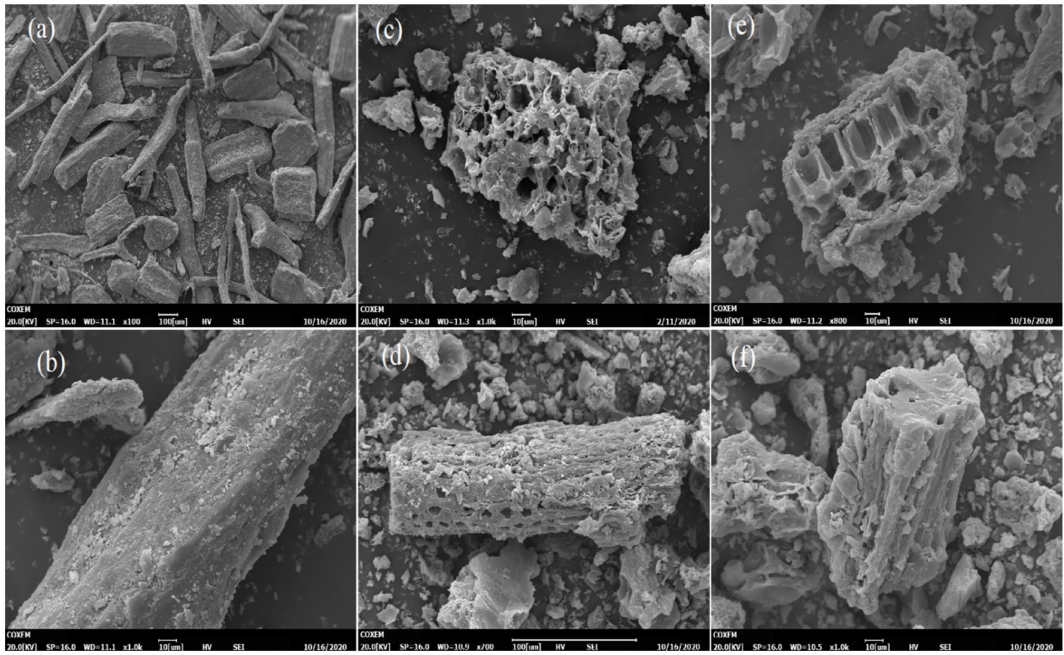
Figure 3. SEM micrographs of activated carbon ( a , b ) from raw Quercus alba ( c ) 16 h, ( d ) 24 h, ( e ) 48 h, and ( f ) 72 h using H 3 PO 4